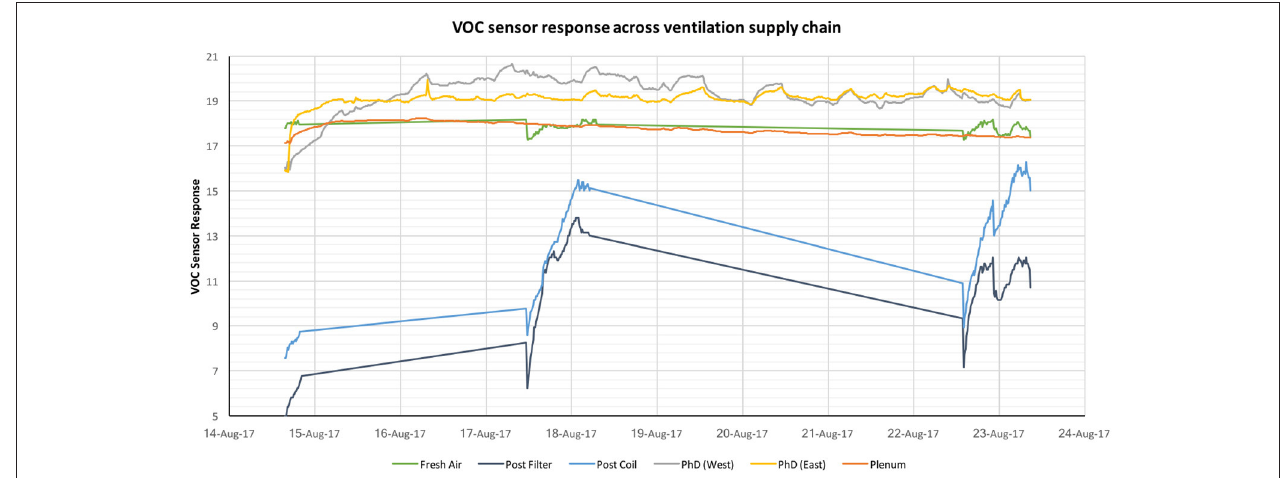
FIGURE 5 | The comparatively calibrated signals of 6 VOC sensors across the ACEE ventilation supply chain.